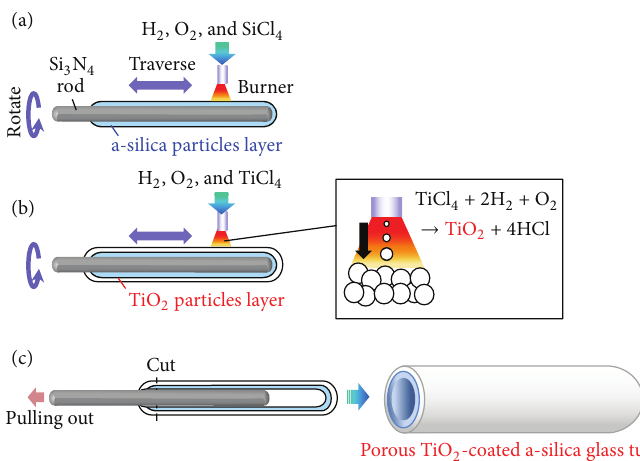
Figure 1: Schematic diagram of the fabrication method for porous TiO 2 -coated a-silica glass tube by the OVD method.